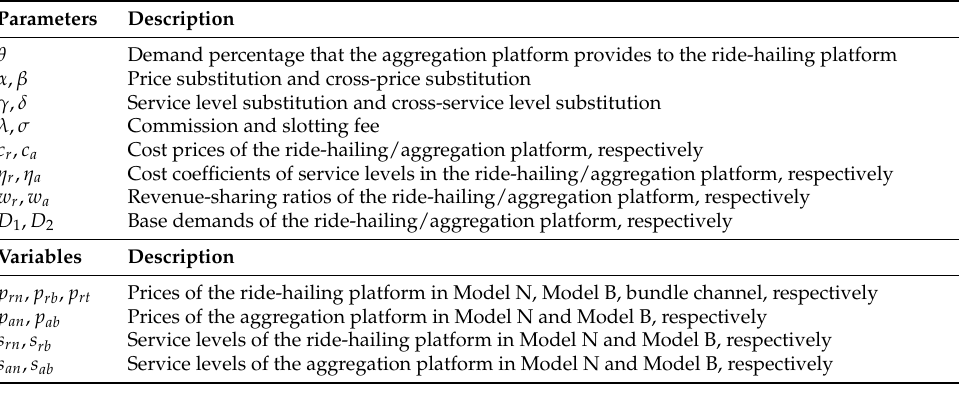
Table 1. Notation and